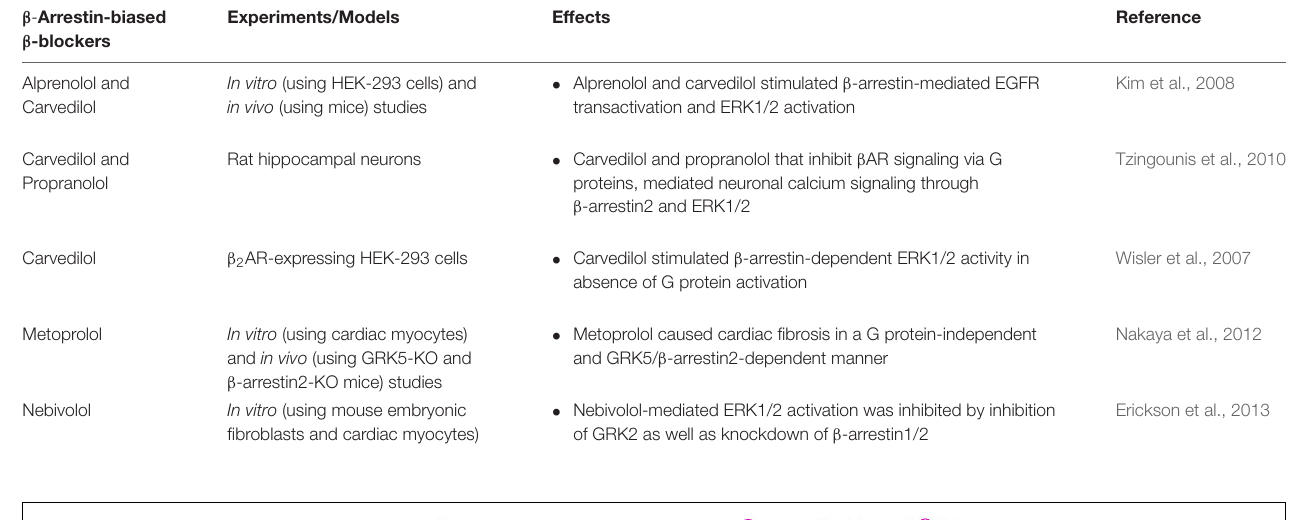
TABLE 3 | Effects of β -arrestin-biased β -blockers.